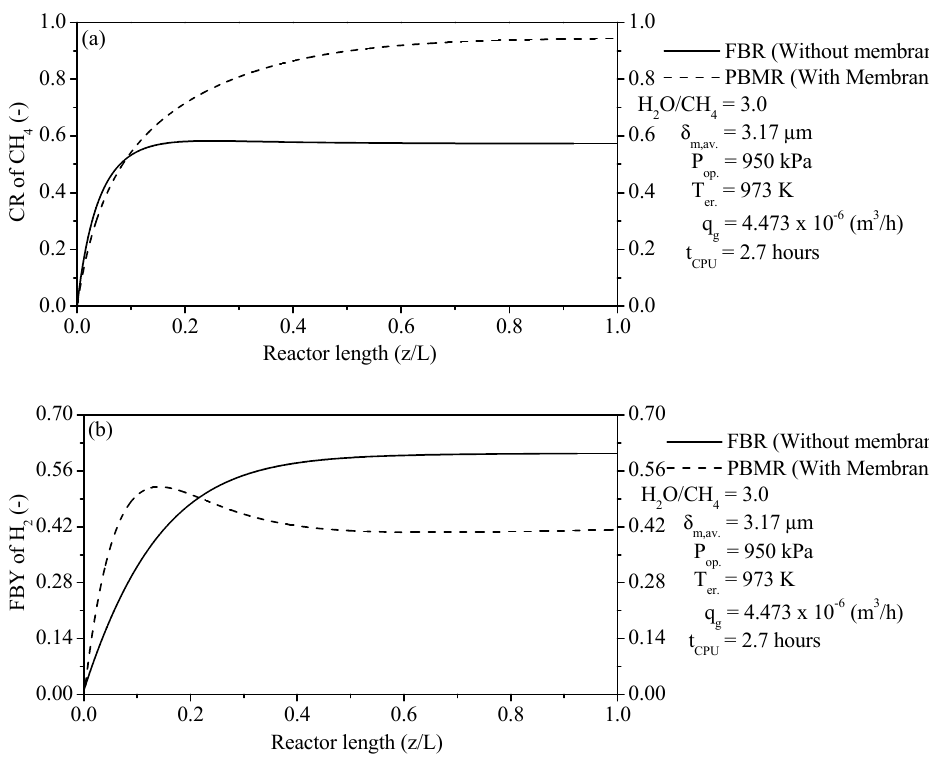
Figure 7. ( a ) Conversion Rate (CR) of CH 4 for FBR and CR of CH 4 in reaction zone from PBMR; ( b ) Feed-Based Yield (FBY) of H 2 for FBR and FBY of H 2 in reaction zone from PBMR. Figure 7b confronts the FBY of H 2 within FBR and FBY of H 2 in reaction zone